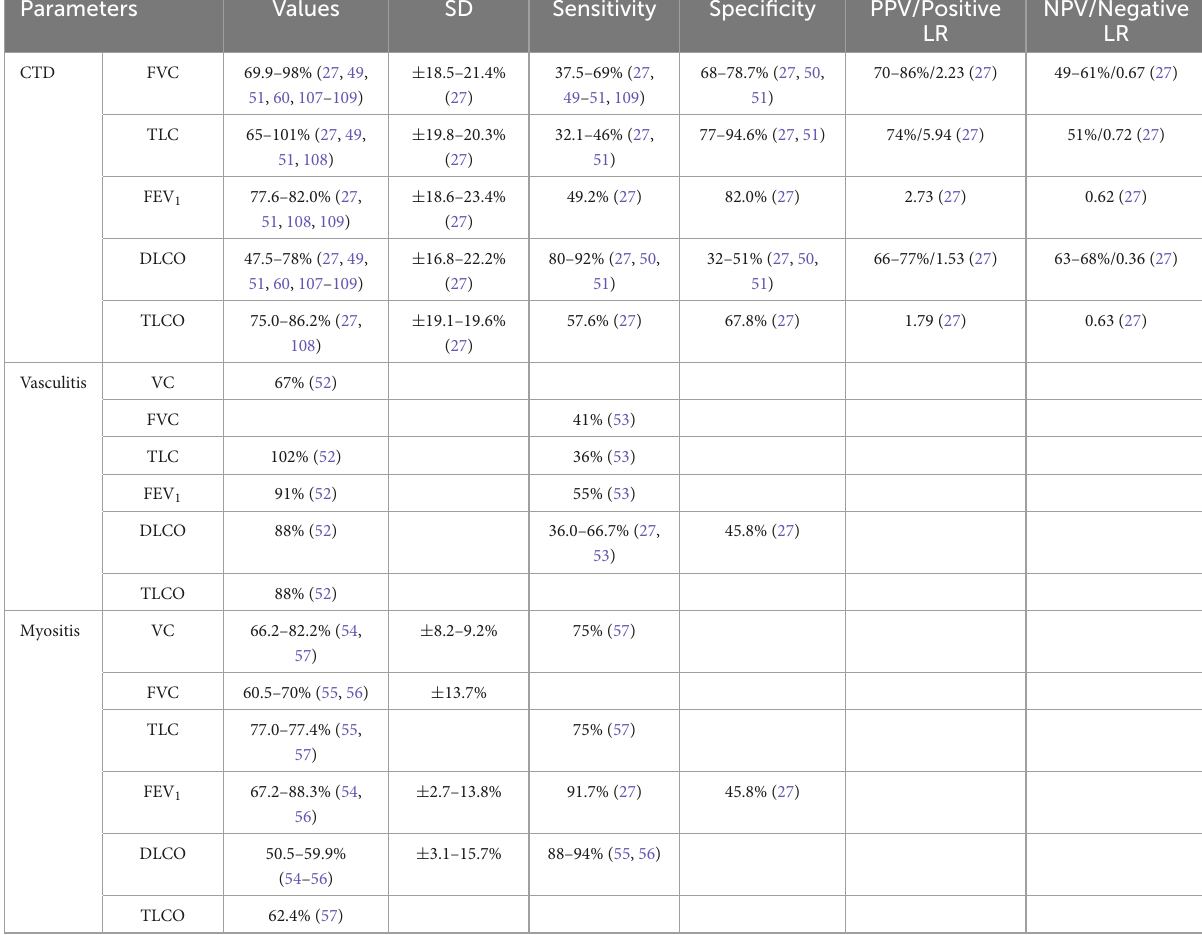
TABLE 2 Values, sensitivities, specificities, positive (PPV) and negative predictive values (NPV) for different parameters in pulmonary function test (PFT) for screening and monitoring interstitial lung disease (ILD) in patients with inflammatory rheumatic diseases (IRD) (cut-off < 80%).